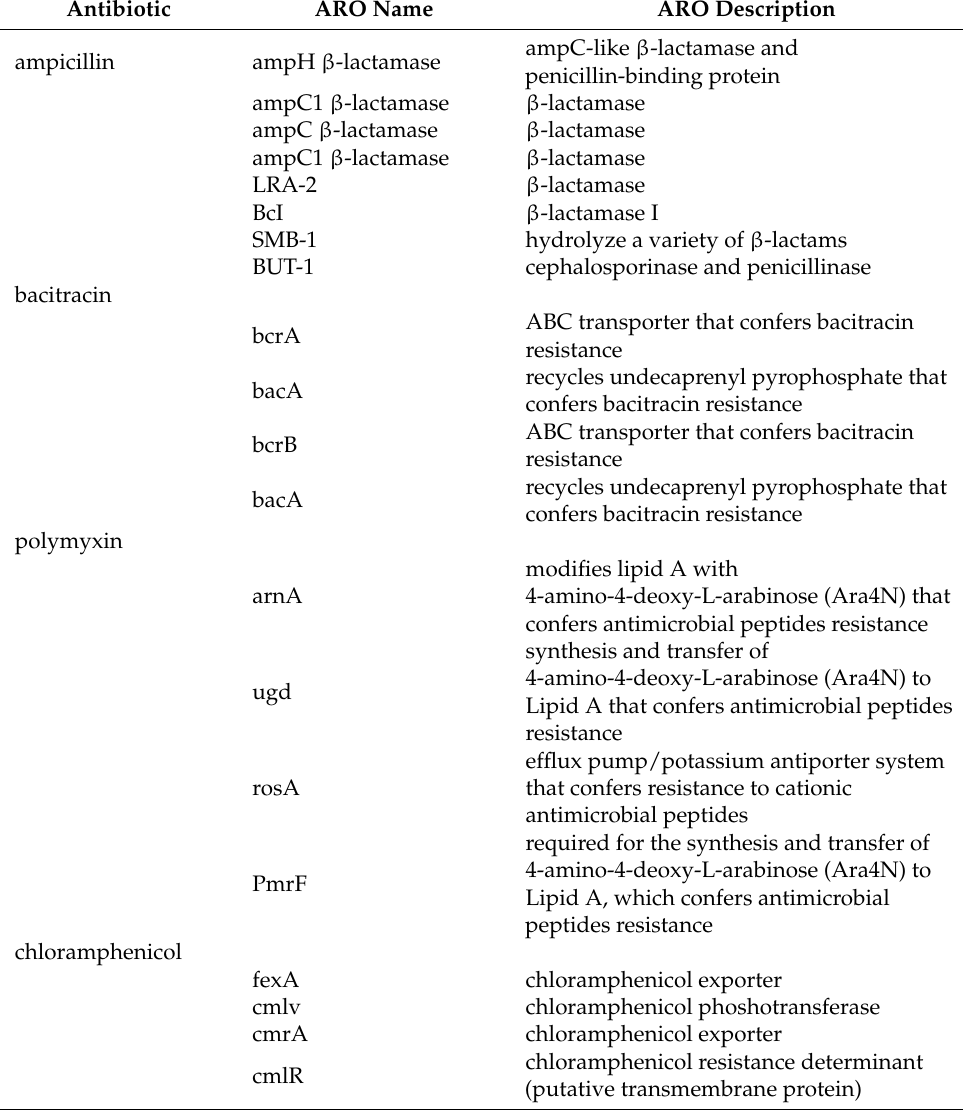
Table 5. The putative antibiotic resistance-related